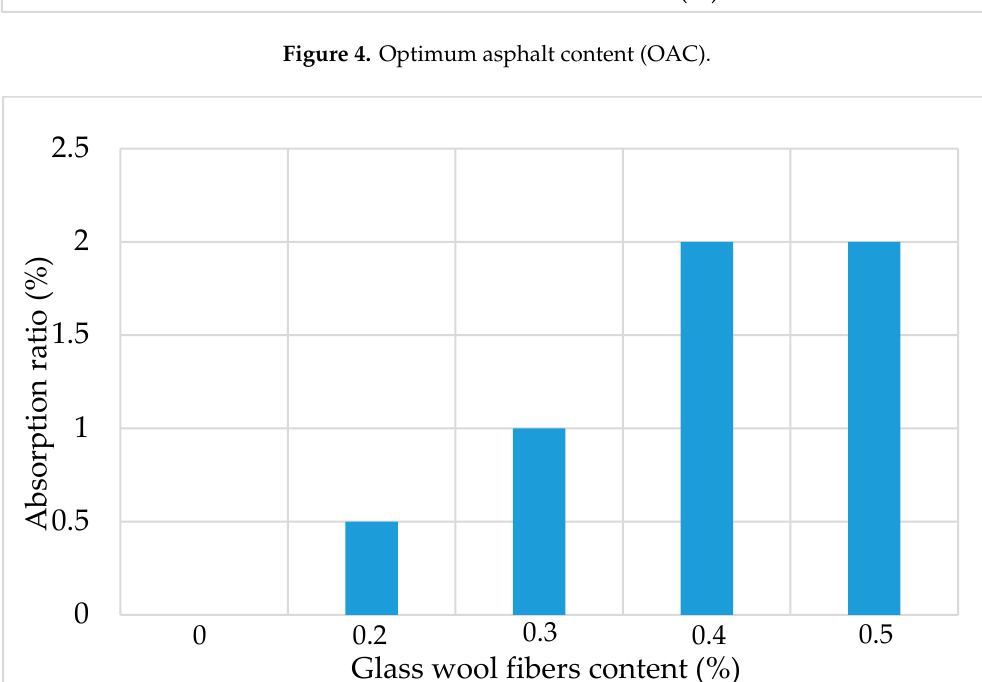
Figure 5. Glass wool fibers’ asphalt absorption ratio .